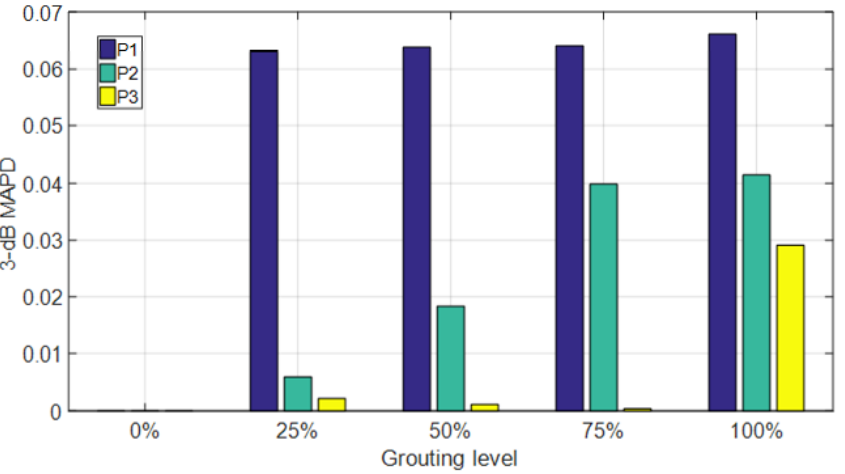
Figure 12. 3-dB MAPD of simulated impedance signatures for different grouting compactness levels.